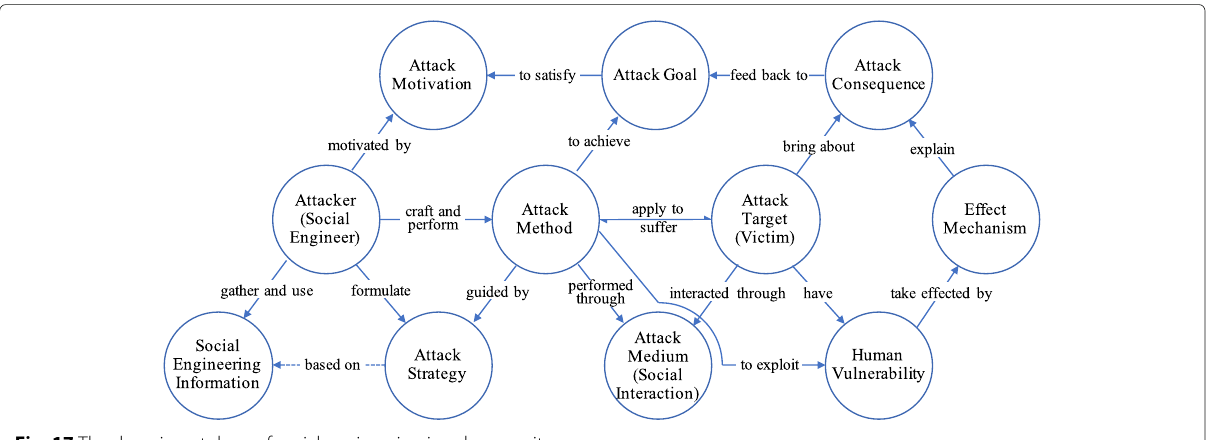
Fig. 17 The domain ontology of social engineering in cybersecurity